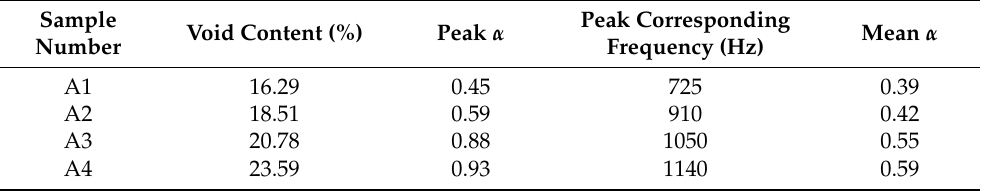
Table 5. Statistical results of the sound absorption coefficient α .